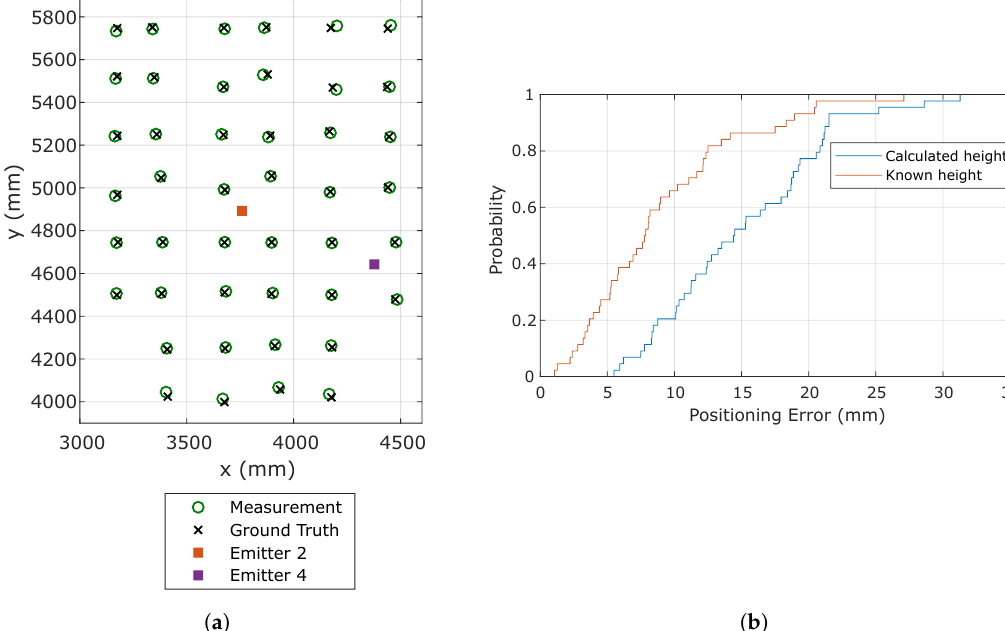
Figure 9. Positioning results using Emitters 2 and 4. ( a ) Estimated and true receiver positions using calculated height; ( b ) CDF of the positioning